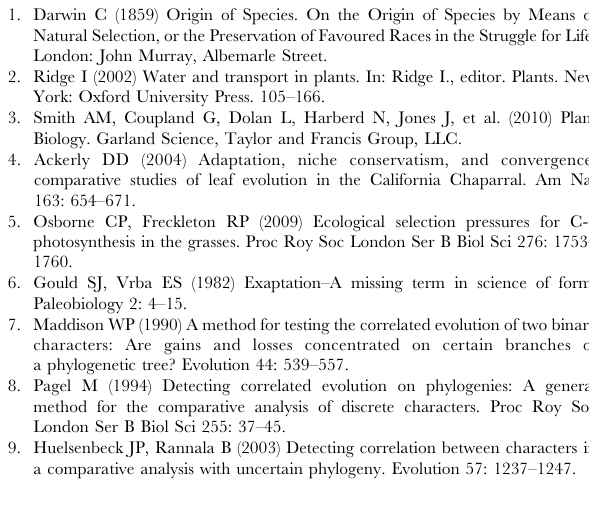
Figure S1 Bayesian tree for moss families Neckeraceae and Lembophyllaceae. Majority consensus of trees sampled after stationarity in the Bayesian analysis of the matrix including indels (for details, see [20] Olsson et al. 2009). Values along the branches indicate posterior probabilities (above the branches) and bootstrap support values from the parsimony analysis (below). The insertion-deletion coding included in the analyses. Correlated the subtree within a shaded box. Numbers indicate the nodes for which probabilities for derived ancestral character state are given in Supporting information Appendix